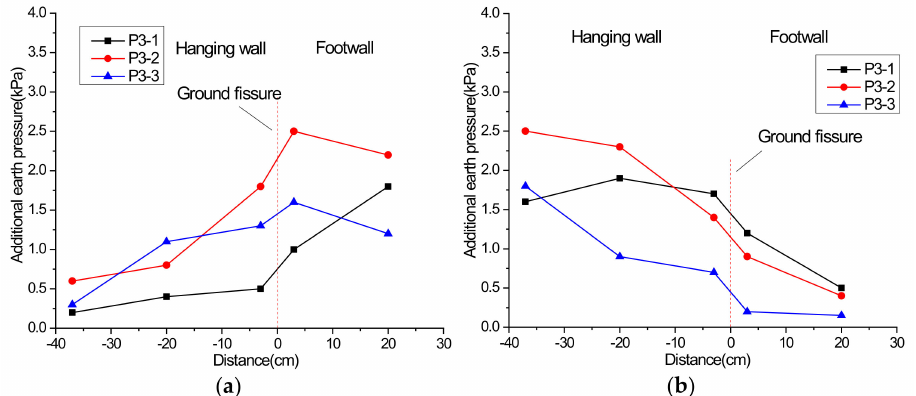
Figure 18. Additional earth pressure at 85 cm height under the scenario of inactive ground fissure: ( a ) vibration exciter at 60 cm; ( b ) vibration exciter at 100